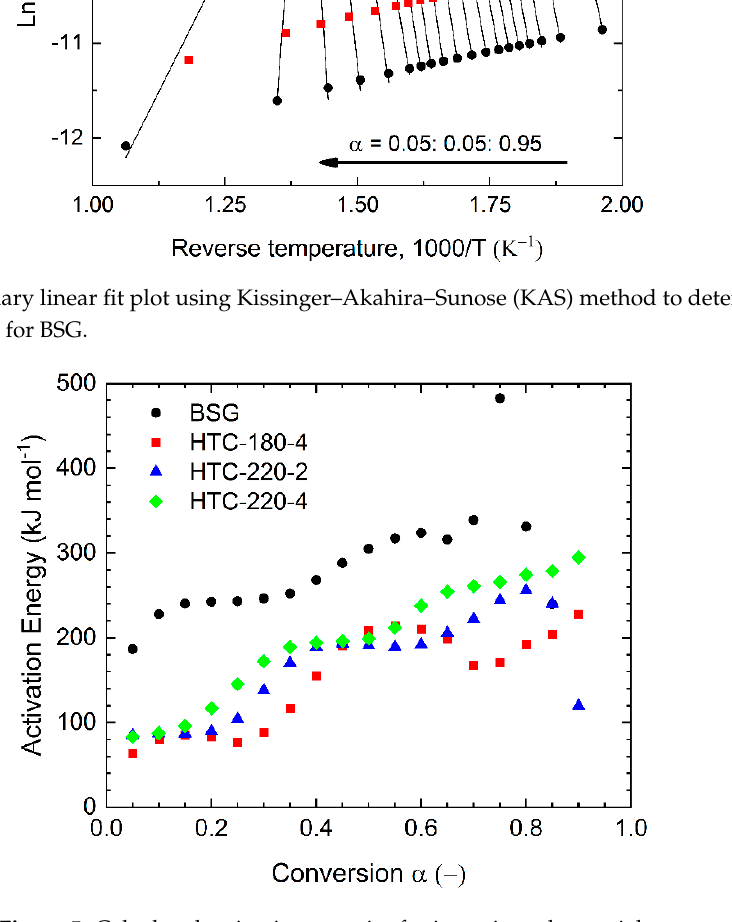
Figure 5. Calculated activation energies for investigated materials.